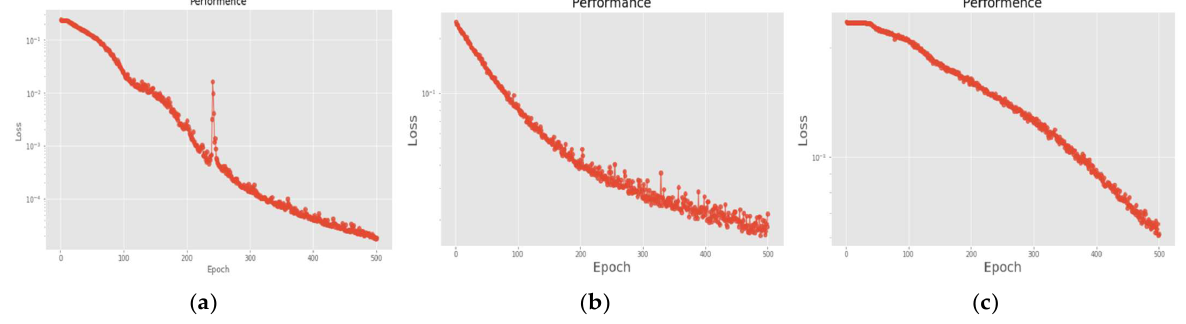
Figure 19. Loss function of wavelet 30 feature dataset. ( a ) Wavelet + DNN. ( b ) Wavelet + CNN. ( c ) Wavelet + LSTM.